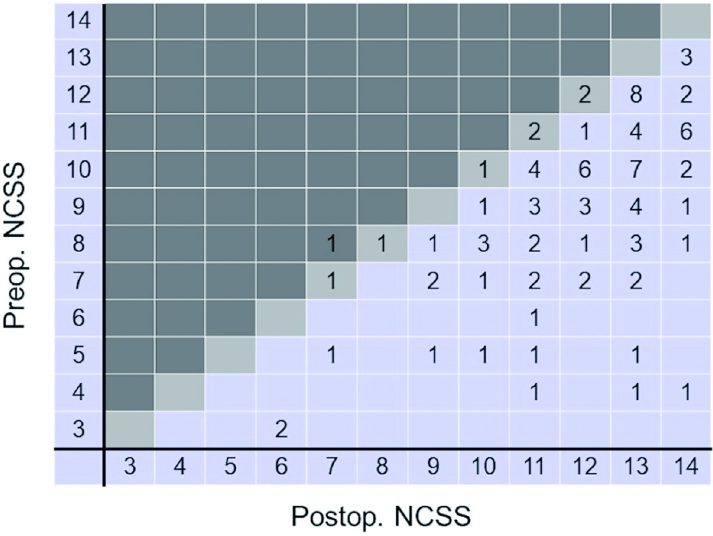
Fig 5. Improvement in the neurosurgical cervical spine scale (NCSS) scores of patients < 80 years of age. Postoperatively, the majority of patients scored > 11 points. Fourteen patients achieved the full score (14 points) postoperatively, indicating complete improvement in their preoperative symptoms (i.e., 100% recovery rate). Postop., postoperative; Preop.,